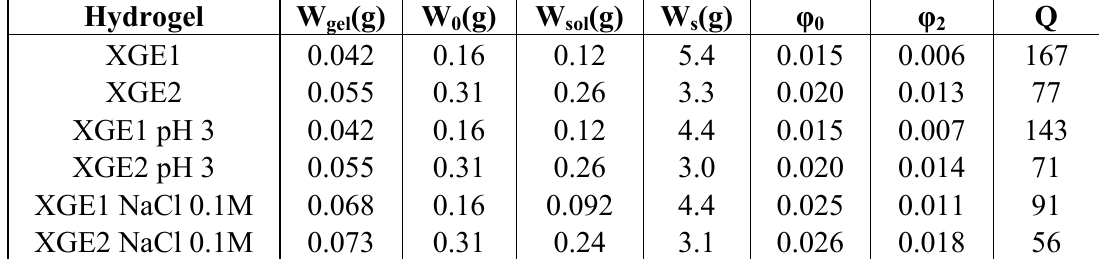
Table 2. Swelling parameters of XGE